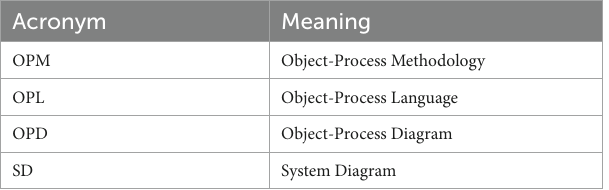
TABLE 1 List of Object–Process Methodology-related